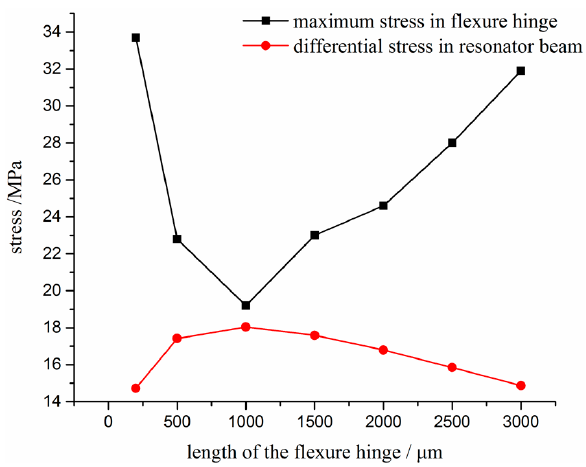
Figure 5. Maximum stress versus different length of flexure hinge (width is 200 μ m; thickness is 500 μ m).